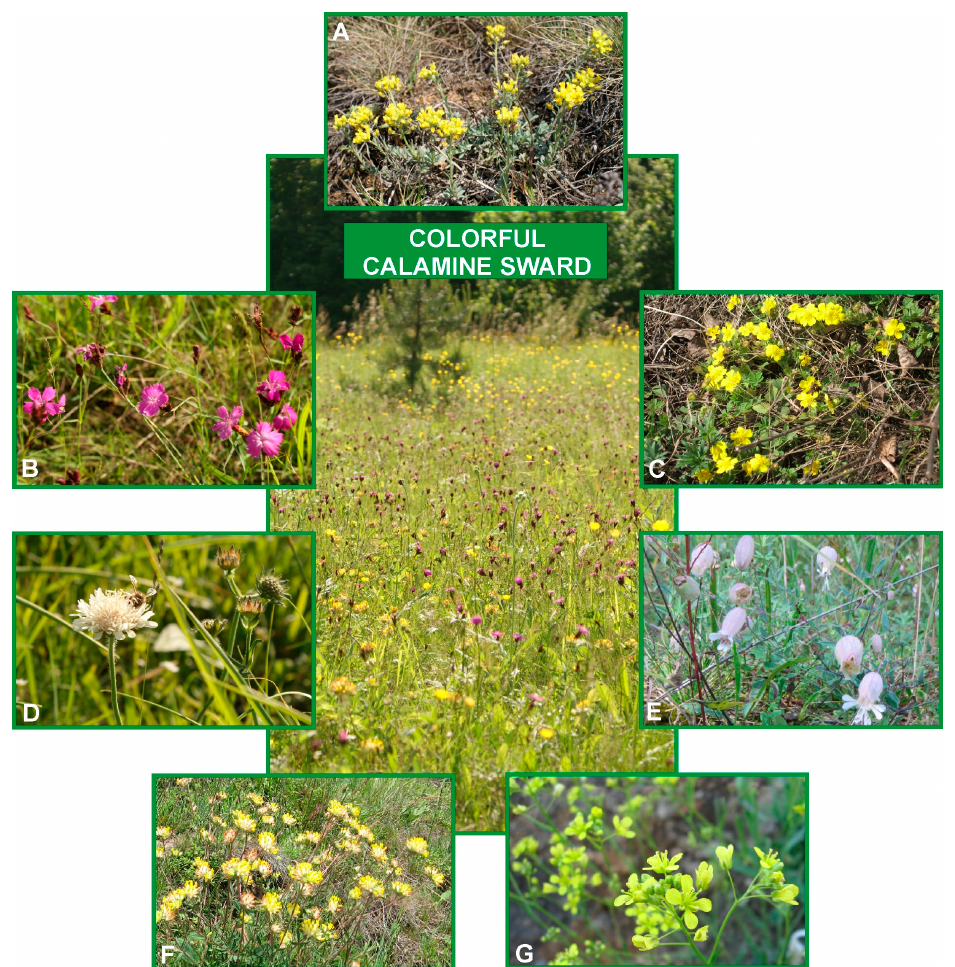
Figure 4. Vegetation cover on more than one hundred years old calamine waste heap in Olkusz Ore-Bearing Region (southern Poland). Examples of metallophytes with excluder behaviour: Alyssum